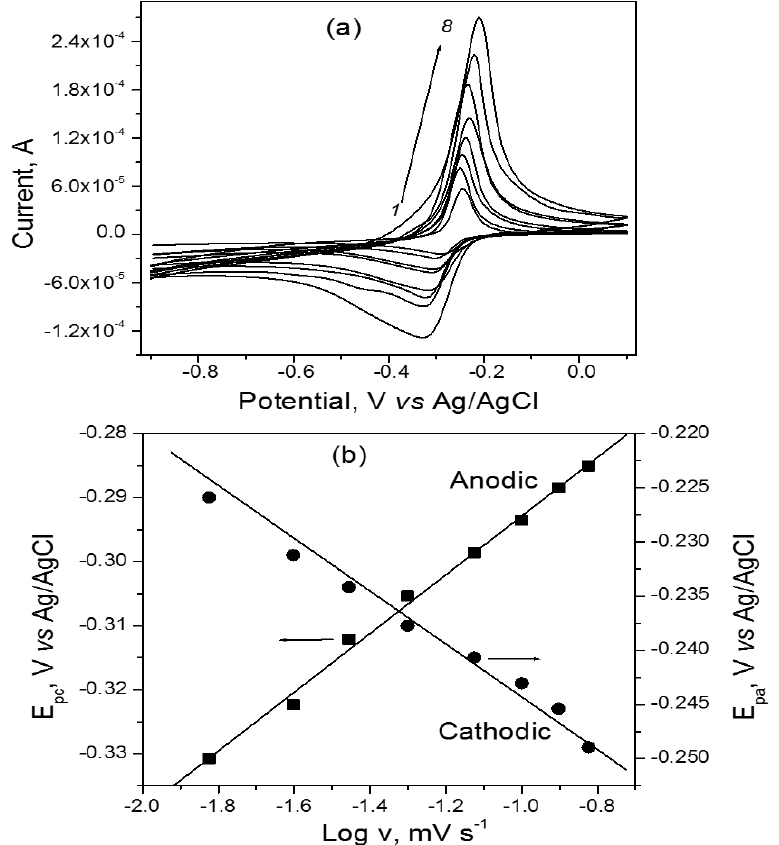
Figure 4. ( a ) Cyclic voltammograms recorded in 0.1 M PBS (at pH 5.5) +1 mM NBA at various scan rates: (1) 15, (2) 25, (3) 35, (4) 50, (5) 75, (6) 100, (7) 125, and (8) 150 mV · s − 1 . The cyclic voltammograms recorded from lowest to highest intensity are those obtained at increasing scan rates between 15 and 150 mV.s -1 respectively. ( b ) Plot scan rate potential as a function of the logarithm of scan rate, from the cyclic voltammograms in ( a